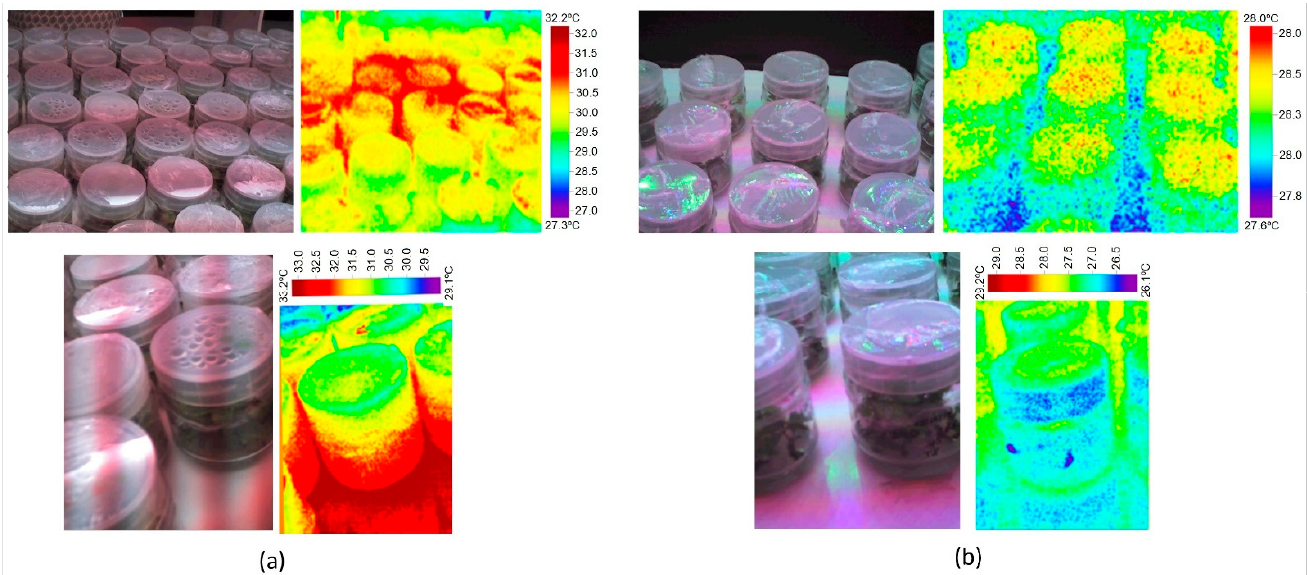
Figure 6. Thermographic images of the temperature outside the vessels under ( a ) Grolux fluorescent lighting and ( b ) LED lighting. (Thermographic camera model 875. Manufacturer Testo).